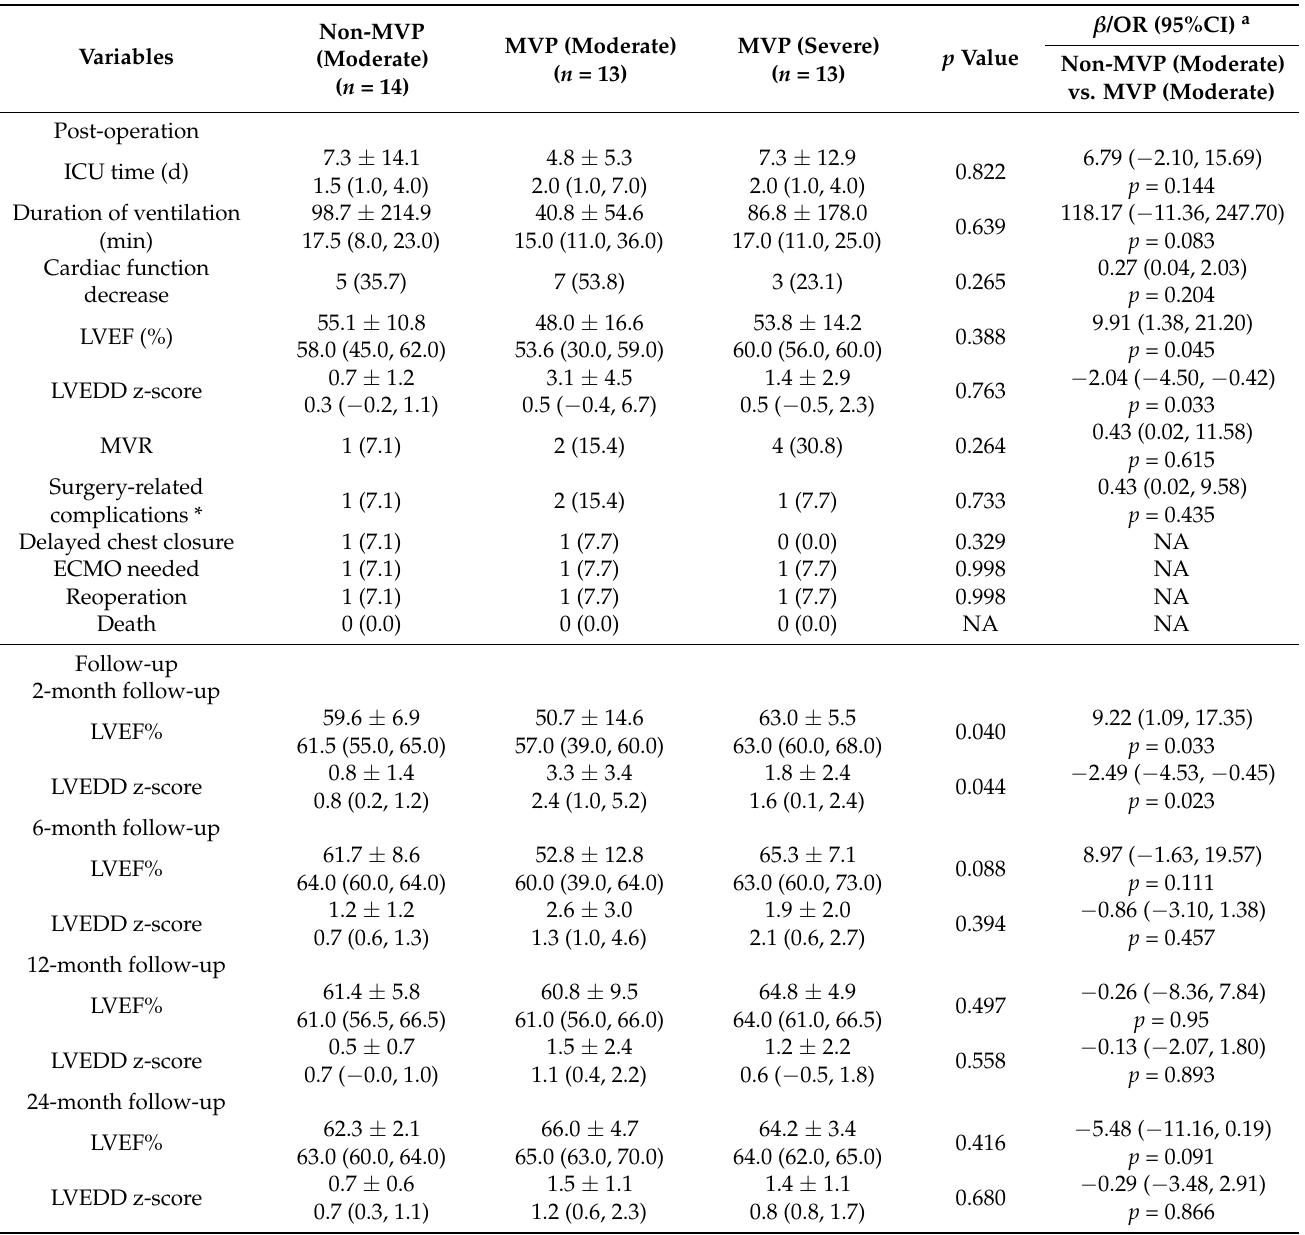
Table 2. Post-operative and follow-up information of ACAPA patients with and without mitral valve